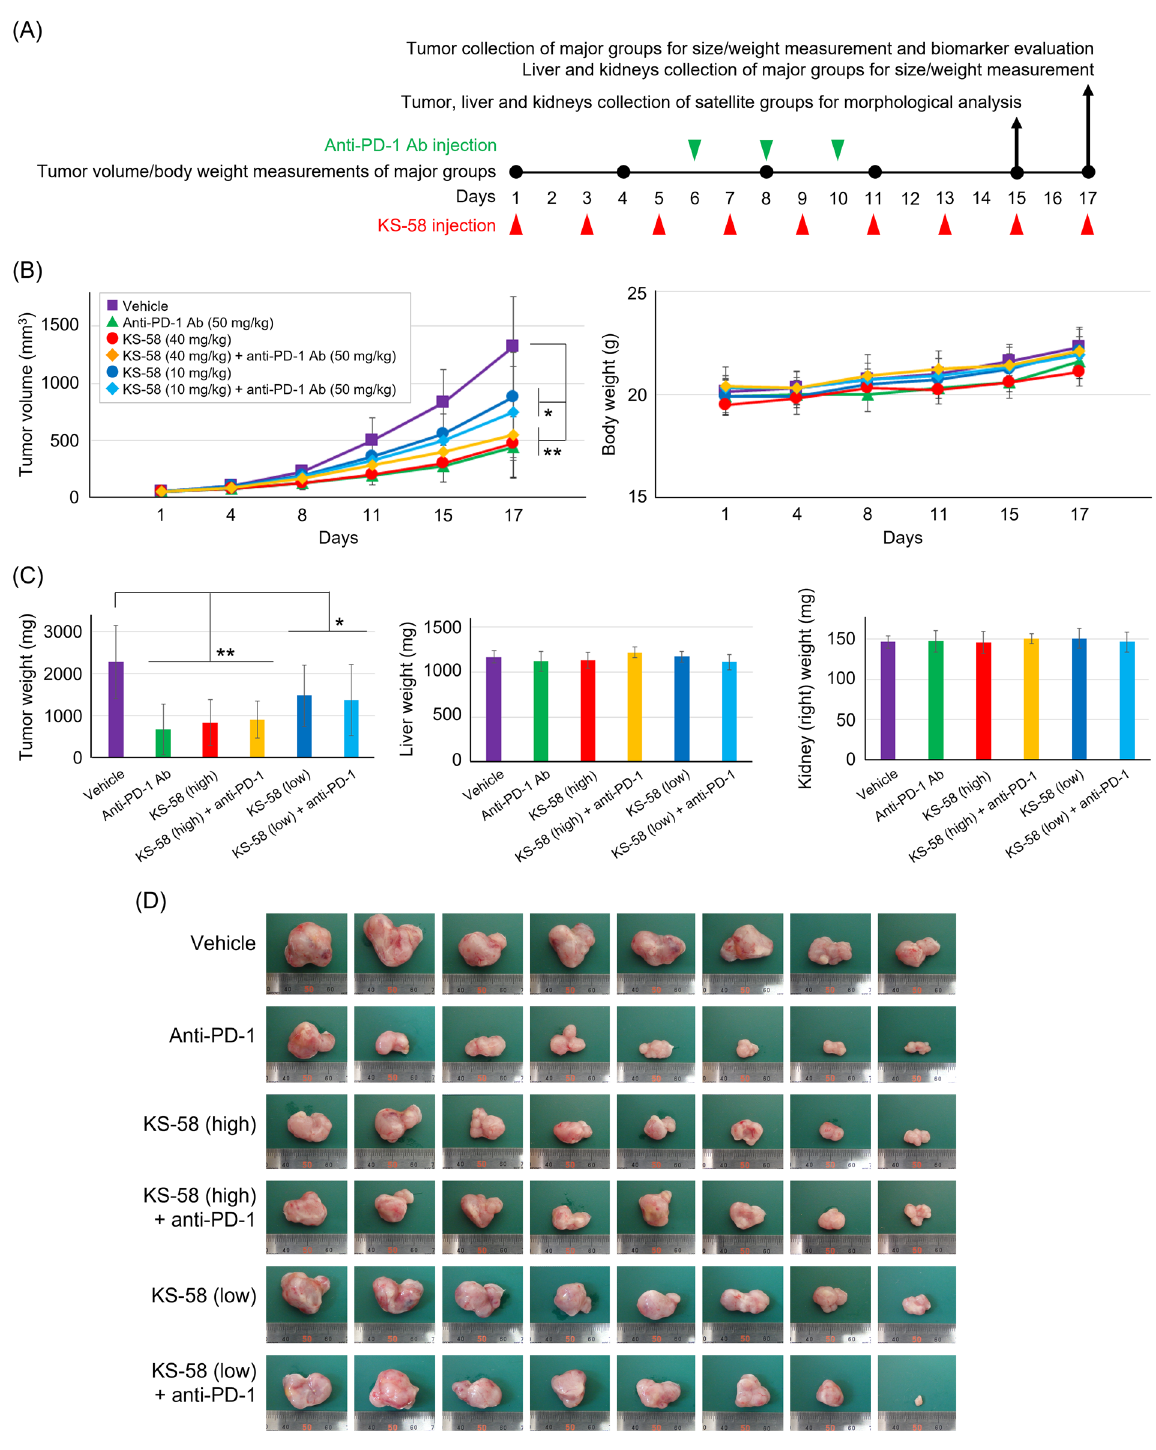
Figure 2. Anticancer activities of KS-58 alone and KS-58 plus anti-PD-1 antibody against CT26 allografts. ( A ) Schematic of experimental procedures. Major groups (n = 8 mice per group) were tested to evaluate anti-cancer activity. Tumors, livers and kidneys of satellite groups (n = 3 mice per group) were collected for morphological analysis of Fig. 4. ( B ) Changes in tumor volume and body weight for each major treatment group (n = 8 mice per group, expressed as mean ± SD, * p < 0.05 and ** p < 0.01 vs. Vehicle control by Dunnett’s test). ( C ) Weights of tumor, liver, and kidney (right) collected from major groups on day 17 (n = 8 mice per group, mean ± SD, * p < 0.05 and ** p < 0.01 vs. Vehicle control by Dunnett’s test). ( D ) Appearance of tumors collected from major groups. KS-58 doses were 40 mg/kg (high) and 10 mg/kg (low) in all